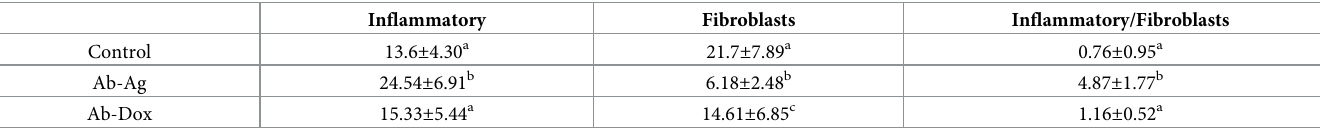
Table 1. The number of the inflammatory and fibroblast cells in grafted MCF7 scaffolds.